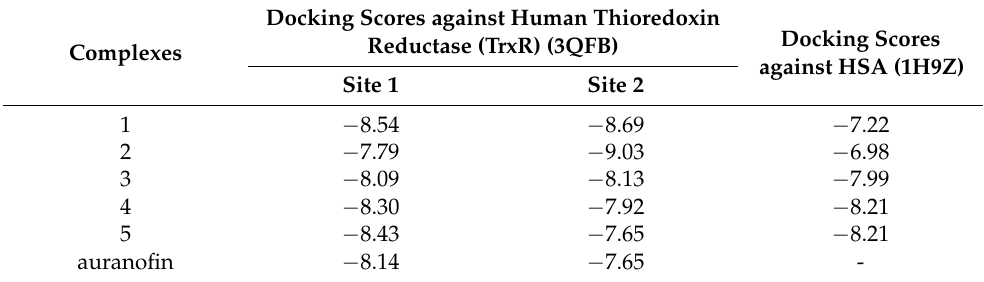
Table 4. Binding scores for Au-complexes as calculated by MOE.